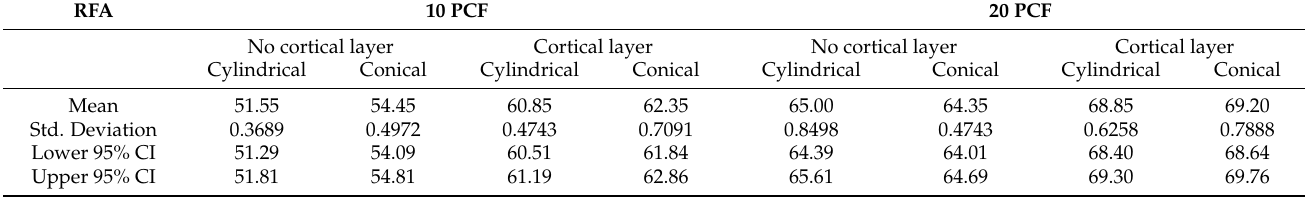
Table 3. Summary of the resonance frequency analysis (RFA) values of the tested cylindrical and conical implants.